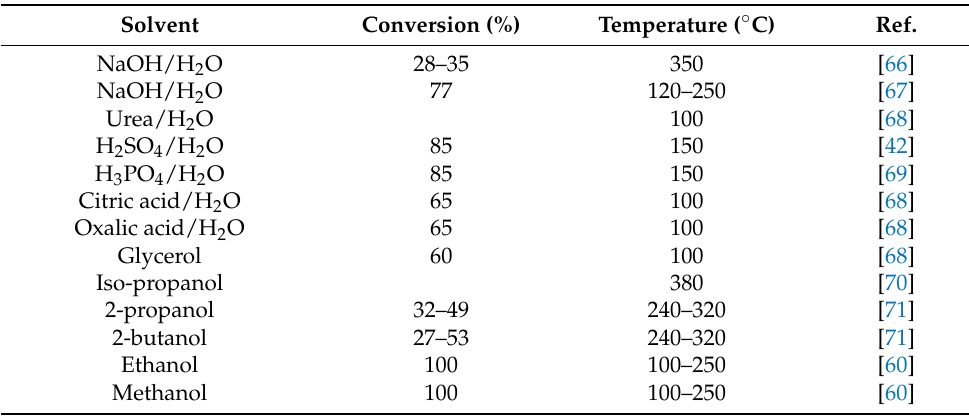
Table 1. Solvent used for biomass/cellulose